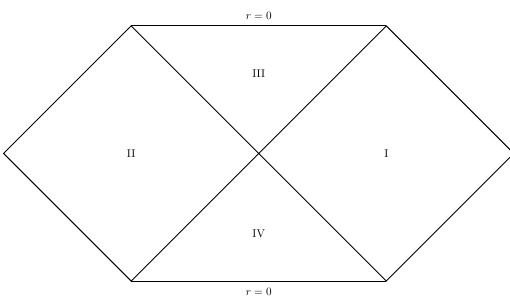
Figure 4. Penrose diagram of the Kruskal-Szekeres spacetime which is obtained by a conformal transformation of the metric (3.6). The left and right square regions are two causally uncorrelated universes. The upper and lower triangle regions are the black hole and white hole,